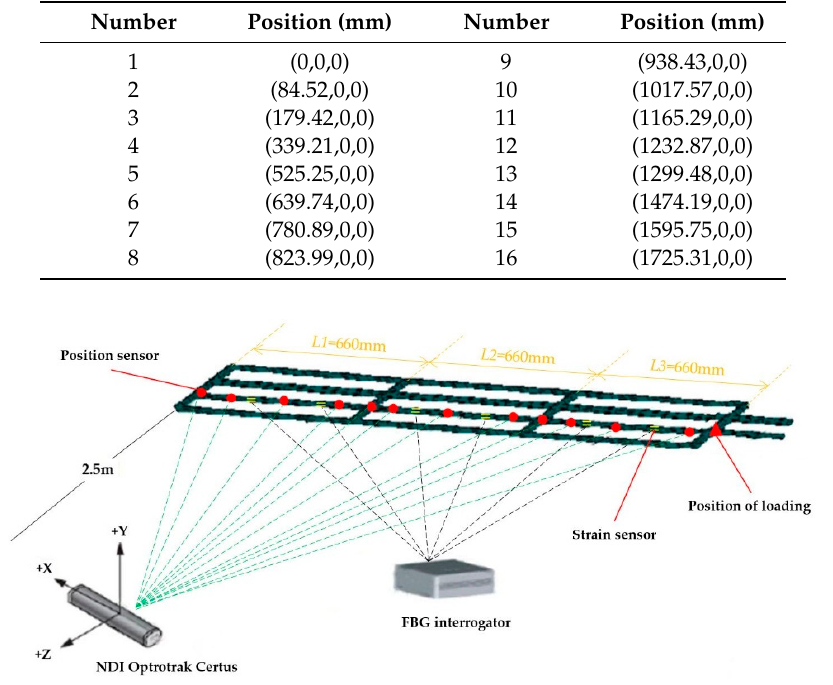
Table 2. Position of position sensors.